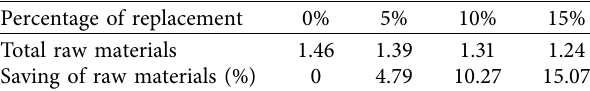
Table 21: Raw material saving in one ton of cement production.